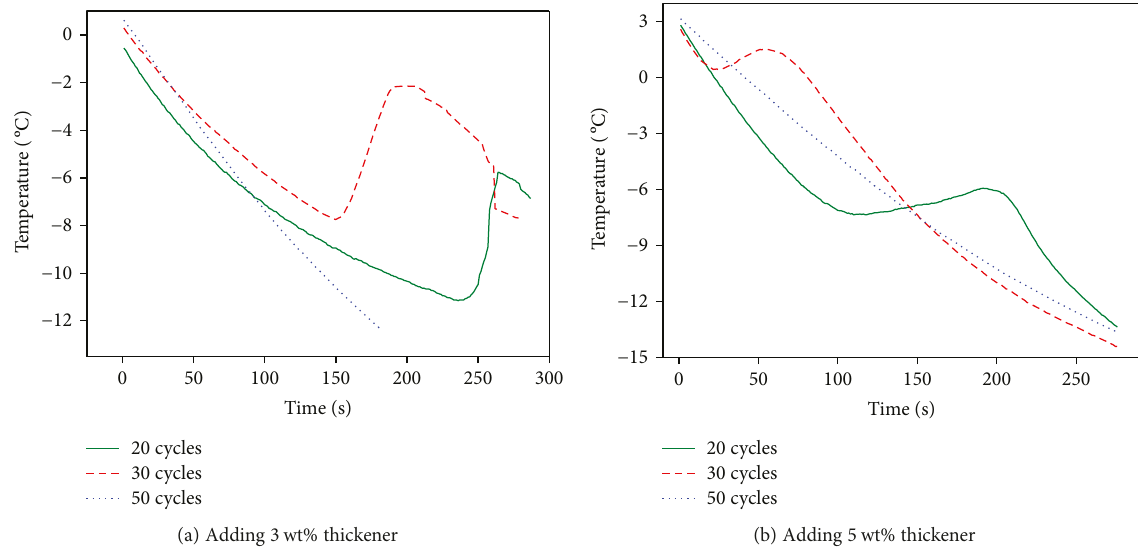
Figure 10: (a) and (b) represent the change of step cooling temperature curve after 20, 30, and 50 freeze-thaw